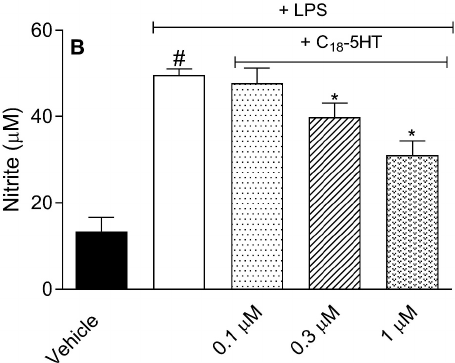
Figure 1. Effect of C 18 -5HT on cell viability ( A ) and NO production ( B ) in a RAW 264.7 cell line. In A, cells were incubated with vehicle or C 18 -5HT (0.01–3 µM) and further incubated with lipopoly, (1 µg/mL) for 24 or 48 h. Cell viability was measured with an MTT assay. In B, cells were incubated with vehicle or C 18 -5HT (0.1–1 µ M) and further incubated with LPS (1 µ g/mL). After 24 h of incubation, nitrite concentration in the supernatant was measured with Griess reagent. The results are expressed as mean ± SD (n = 3) from three independent experiments. In ( A ), * p < 0.05 when compared with the vehicle-treated group. In ( B ), * p < 0.05 when comparing the C 18 -5HT-treated group with LPS-treated group or # p < 0.05 when comparing the LPS-treated group with the vehicle- treated group.